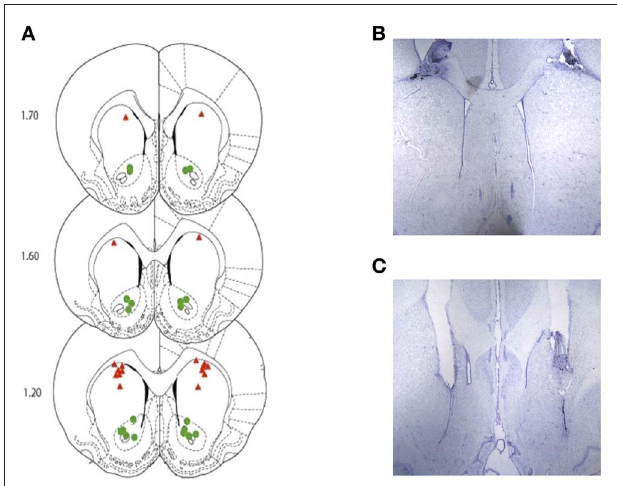
FIGURE 5 | (A) Depicts the approximate location of the injector tips for the DS-CON and DS-ANI treatment groups (red triangles) as well as the VS-CON and VS-ANI treatment groups (green circles) across both experiments. (B and C) Representative coronal brain sections depicting the injector tracts terminating in the DS and VS, respectively. ANI = anisomycin; CON = control; DS = dorsal striatum; VS = ventral